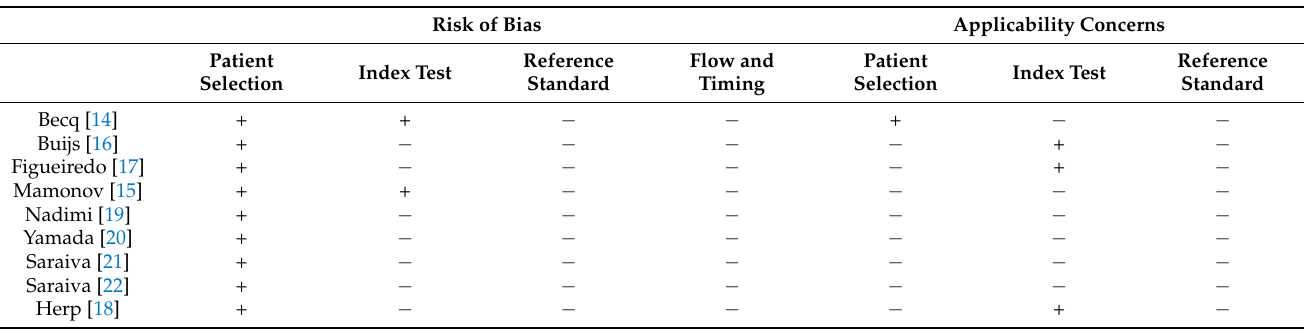
Table 3. QUADAS-2 (Quality Assessment of Diagnostic Accuracy Studies) analysis for the assessment of the risk of bias in the included studies.